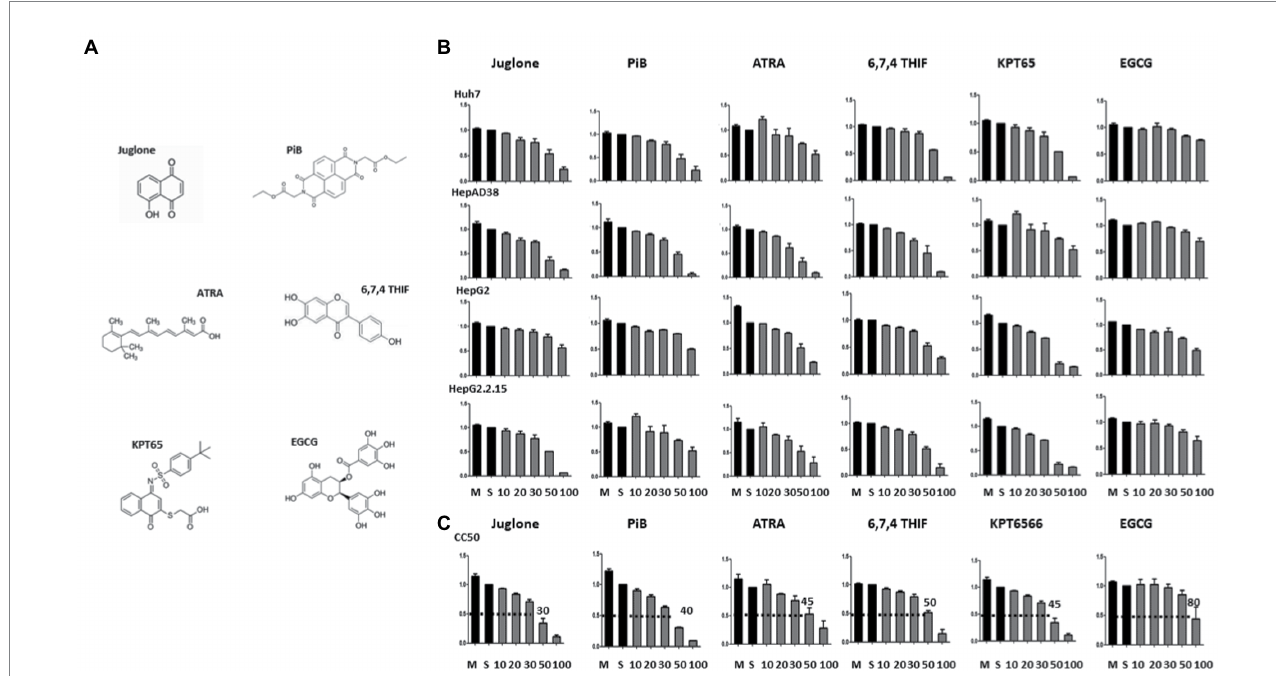
FIGURE 2 MTT assay to measure the cytotoxicity of parvulin inhibitors (Juglone, PiB, ATRA, 6,7,4 ′ -THIF, KPT6566, and EGCG). (A) The chemical structures of parvulin inhibitors including Juglone, PiB, ATRA, 6,7,4 ′ -THIF, KPT6566, and EGCG are shown. (B) Huh7, HepAD38, HepG2, and HepG2.2.15 cells were exposed to varying concentrations (10 μ M, 20 μ M, 30 μ M, 50 μ M, and 100 μ M) of inhibitors Juglone, PiB, ATRA, 6,7,4 ′ -THIF, KPT6566, and EGCG for 48 h and values were determined via MTT assay. (C) The concentrations of Juglone, PiB, ATRA, 6,7,4 ′ -THIF, KPT6566, and EGCG at which cell viability was reduced to 50% (CC50) to that of the control (cells treated by the solvent) were